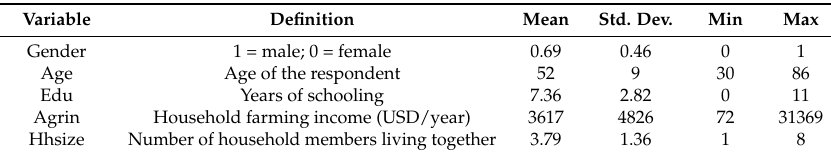
Table 1. Socioeconomic characteristics of